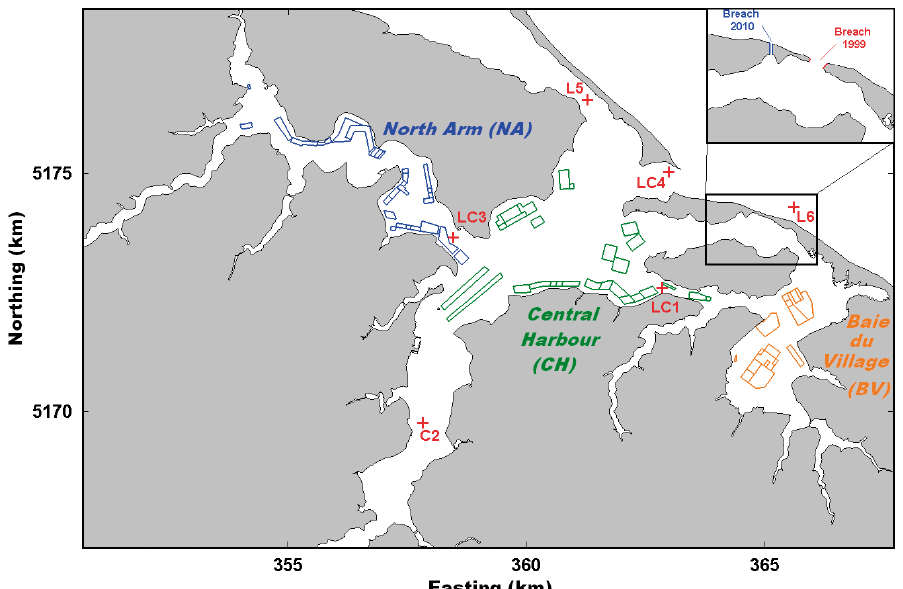
Fig. 2. Location of 2010 monitoring stations (L: tide gauge, C: current meter) and oyster farms (polygons) in the 3 main areas of the estuary: the North Arm (NA), Central Harbour (CH) and Baie du Village (BV). Inset shows the evolution of the breach